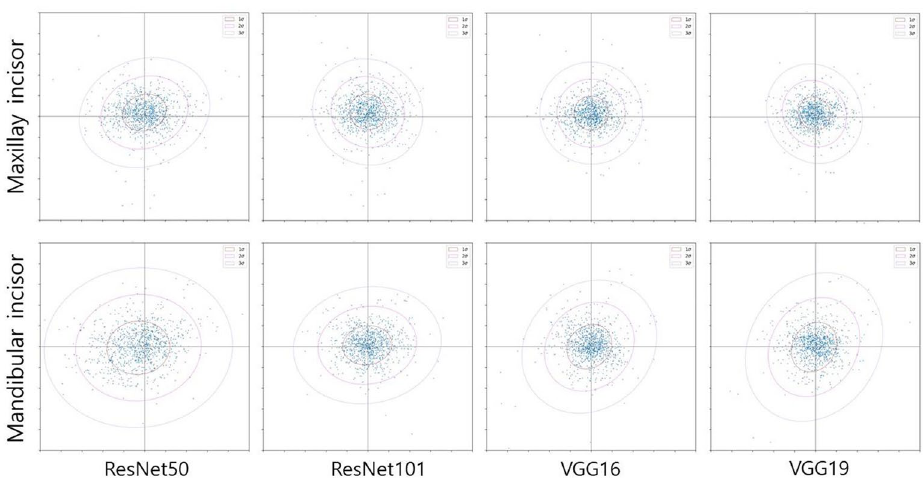
Figure 4. Maxillary and mandibular incisor scattergrams and confidence ellipses for the mean errors obtained from each landmark detection model. The maxillary models and ResNet network result in a more uniformly distributed pattern of errors than the mandibular models and VggNet.